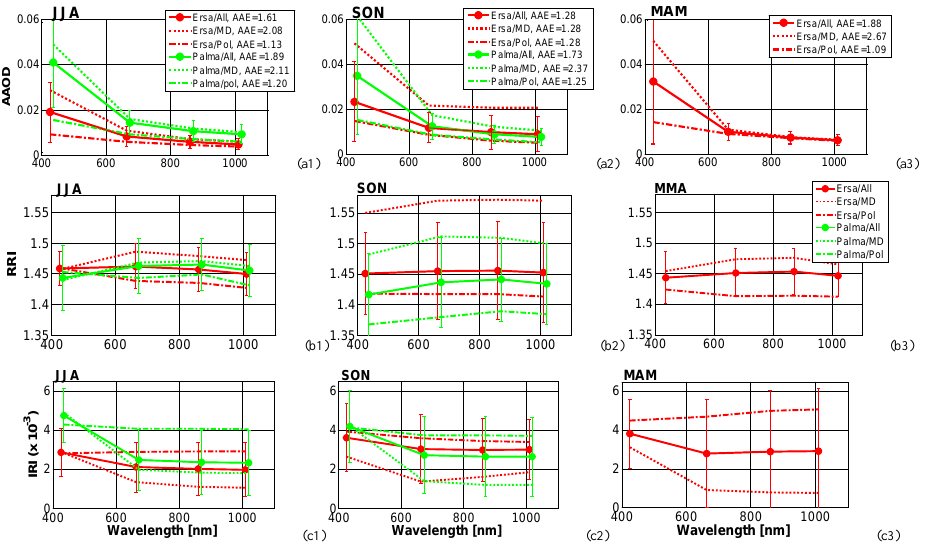
Figure 9. Seasonal variation of the spectra of (a) the aerosol absorption optical depth (AAOD), (b) the real part of the refractive index (RRI) and (c) the imaginary part of the refractive index (IRI) during (1) summer, (2) autumn and (3) spring, derived from AERONET level 2.0 daily inversion products available for the period 2011–2015. The legend in plot (b3) applies for all plots (b) and (c) . All three parameters are retrieved with the following restrictions: 50<solar zenith angle<80 ◦ and aerosol optical depth at 440nm (AOD 440 ) >0.4. The error bars represent the standard deviation. The seasonal mean is represented for the whole dataset (All), and separately for strong mineral dust (MD) and strong pollution (Pol) cases determined with the classification obtained from Fig. 8 (see first paragraph of Sect. 5.3).